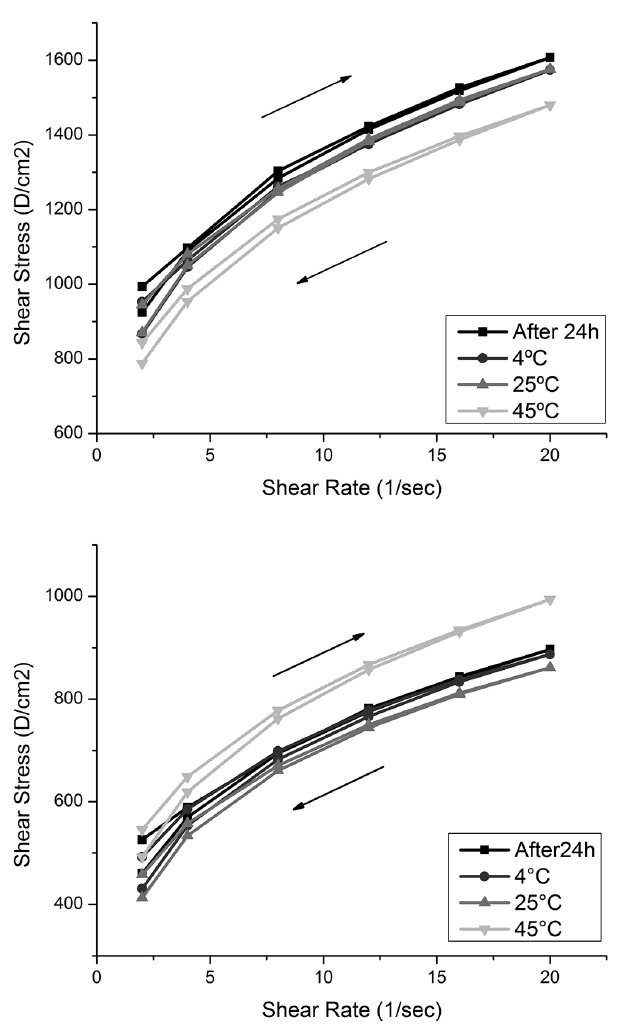
FIGURE 1 - ( a ) F4 formulation rheogram after 24 hours and 90 days, stored at 4, 25 and 45 ºC. ( b ) F10 formulation rheogram after 24 hours and 90 days, stored at 4, 25 and 45